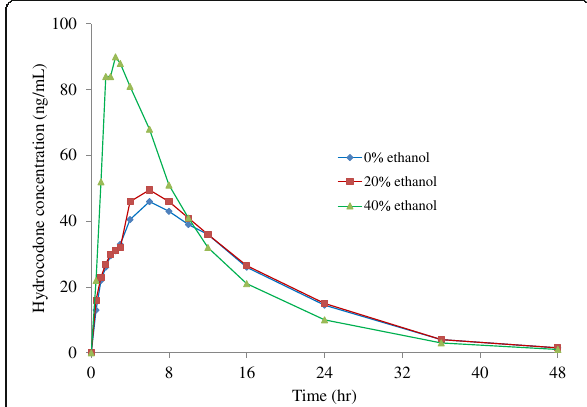
Fig. 3 Mean serum hydrocodone concentration time profiles (data from reference (Farr et al. 2015))